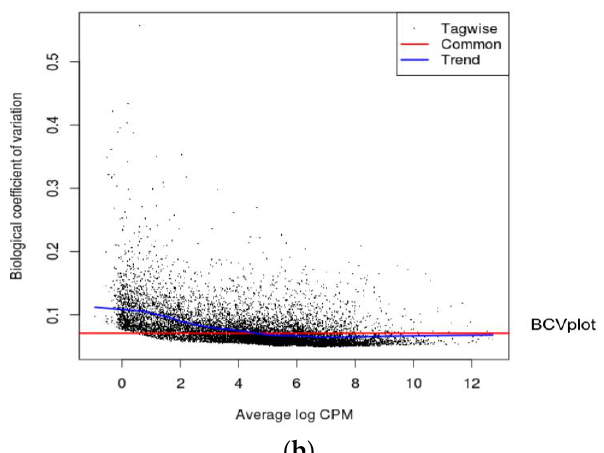
Figure 2. Biological Coefficient of Variation plots: ( a ) For JQ1 treatment; ( b ) For Dexamethasone treatment. CPM- counts per million.